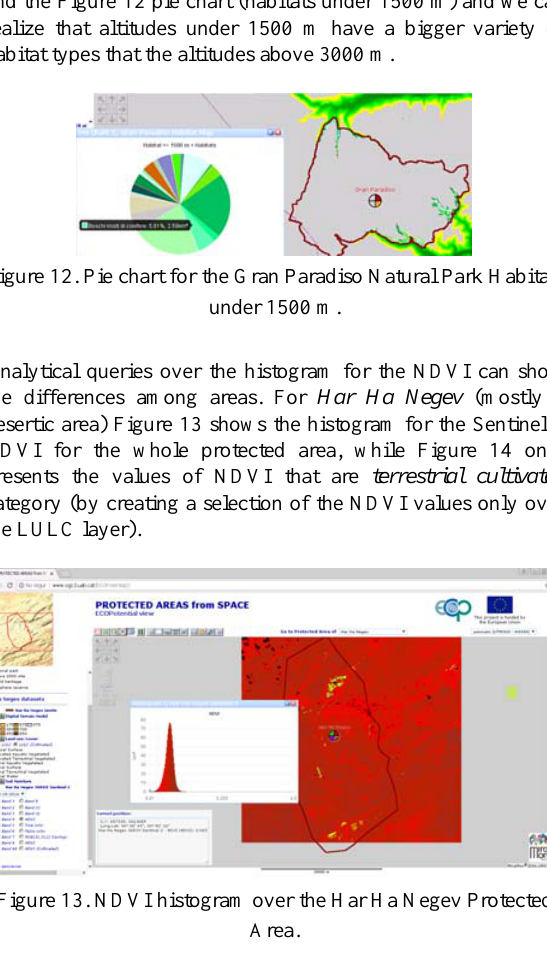
Figure 14. NDVI histogram over the Har Ha Negev Protected Area, only for the terrestrial cultivated category extracted from the LULC layer.